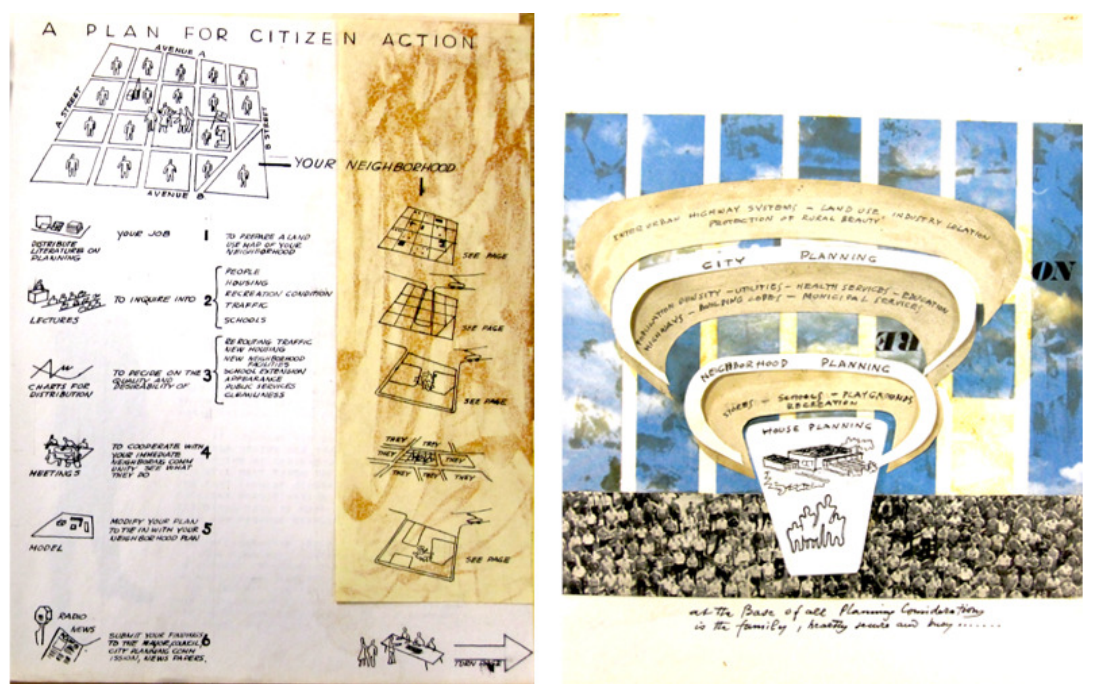
Figure 10. Planning diagrams: “A Plan for Citizen Action.” Source: Kahn [ca. 1944]. the post‐war American city is expressed in the two